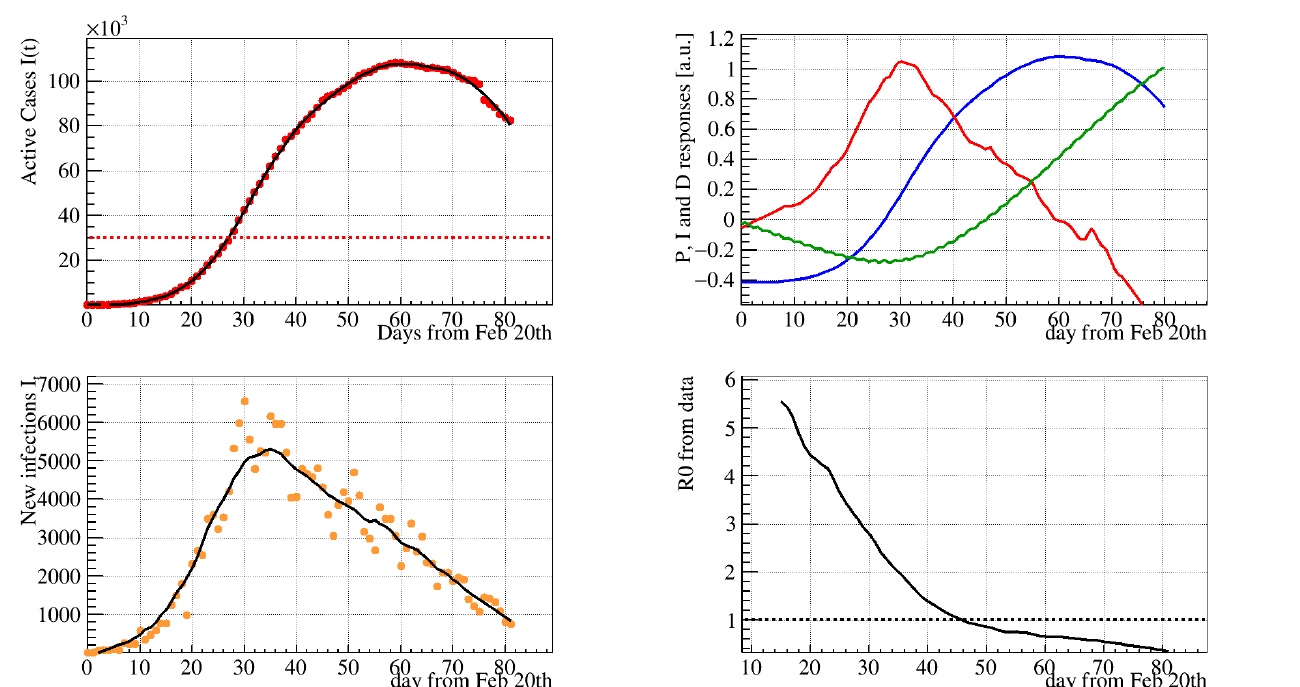
Figure 7. Top left : Active cases in Italy during the first epidemic wave in 2020. The black curve represents its smoothing obtained with the local regression method (LOESS). The dashed horizontal line represents a hypothetical set-point of, e.g., 30,000 cases. Top right : (in arbitrary units) The error function e ( t ) (blue) of I ( t ) with respect to the chosen set-point and its integral (green) and derivative (red), corresponding to the proportional, the integral, and the derivative responses, respectively, as required by the PID method. All of the three functions are built from the smoothed I ( t ) . Bottom left : Daily new infections, I t , with its LOESS smoothing (black). Bottom right : R 0 evolution deduced from I t ; see text for